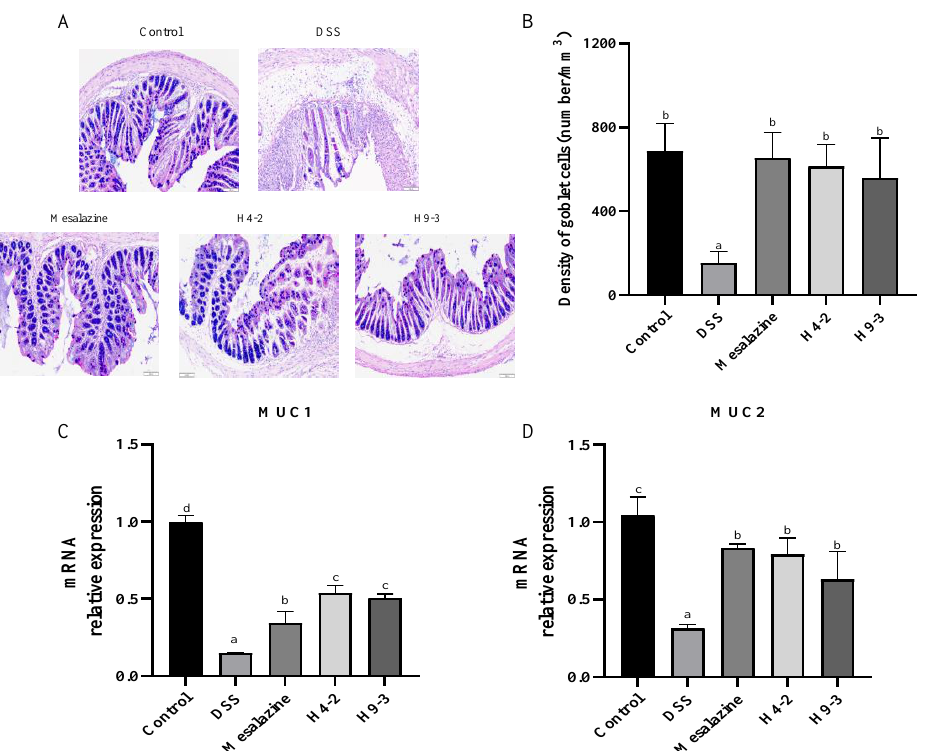
Figure 4. Effects of B. breve intervention on mice mucous layer including pathological section of AB- PAS staining ( A ), the number of goblet cells ( B ) and mRNA expression of MUC1 ( C ) and MUC2 ( D ). Different lowercase letters (a, b, c, d) above the columns indicate significant differences ( p < 0.05), and the same superscript letters indicate that the differences between the values are not statistically sig- nificant ( p > 0.05).